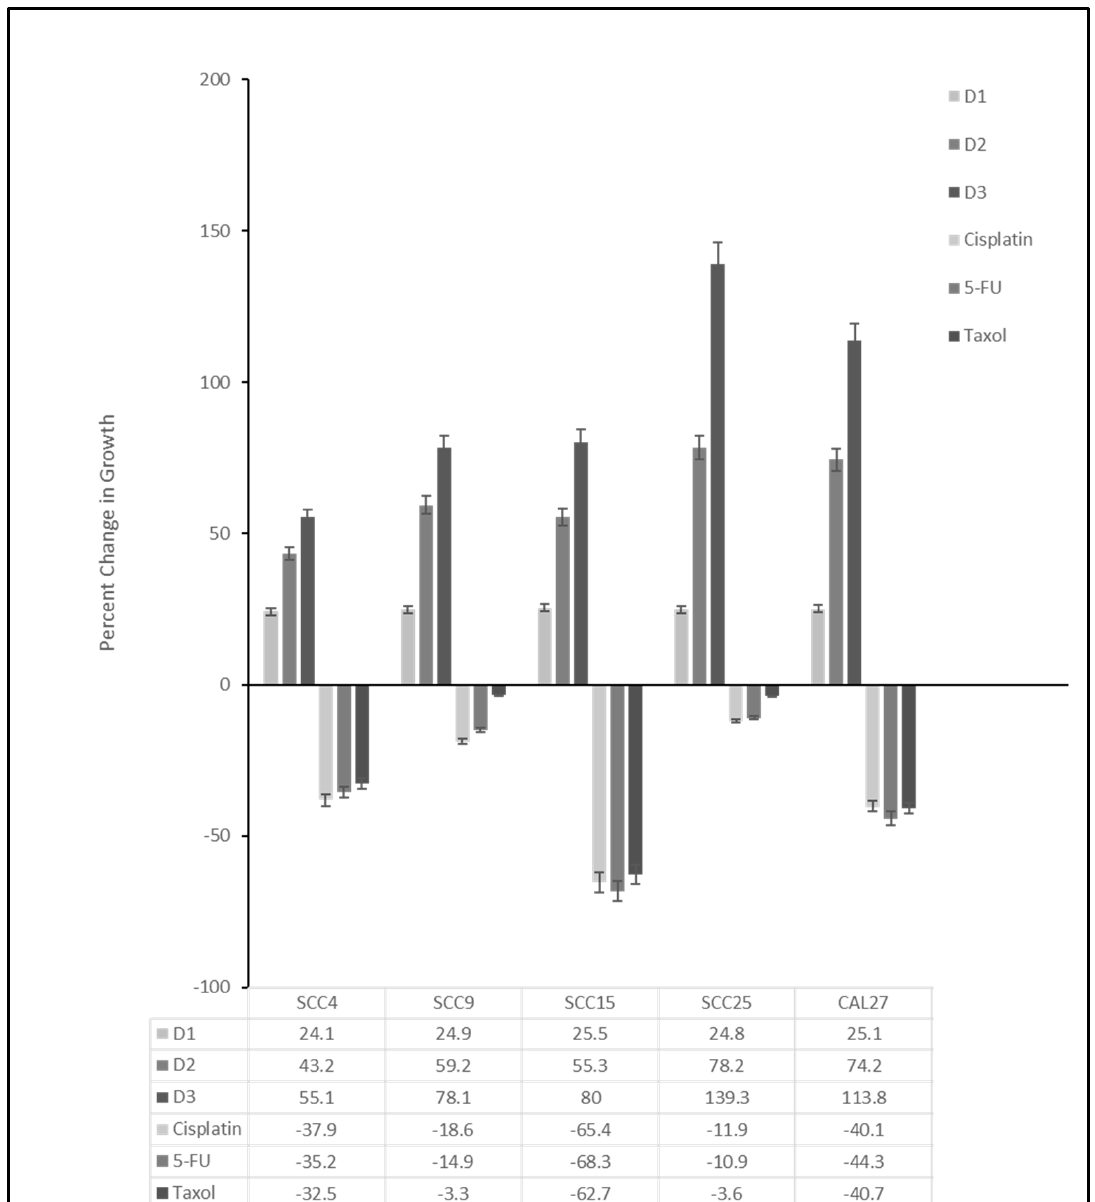
Figure 1. Growth rates and chemotherapy resistance of oral cancer cell lines. Three ‐ day proliferation assays revealed rapid growth with the highest percent change among SCC25 (139.3%) and CAL27 (113.8%) cells. Administration of chemotherapy agents Cisplatin, 5 ‐ FU (Fluorouracil) and Taxol (Paclitaxel) demonstrated robust inhibition among SCC15 cells ( − 65.4%, − 68.3% and − 62.7%) but not SCC9 ( − 18.6%, − 14.9% and − 3.3% *) or SCC25 cells ( − 11.9%, − 10.9% and − 3.6%*), which were all statistically significant except those denoted by * ( p > 0.05).